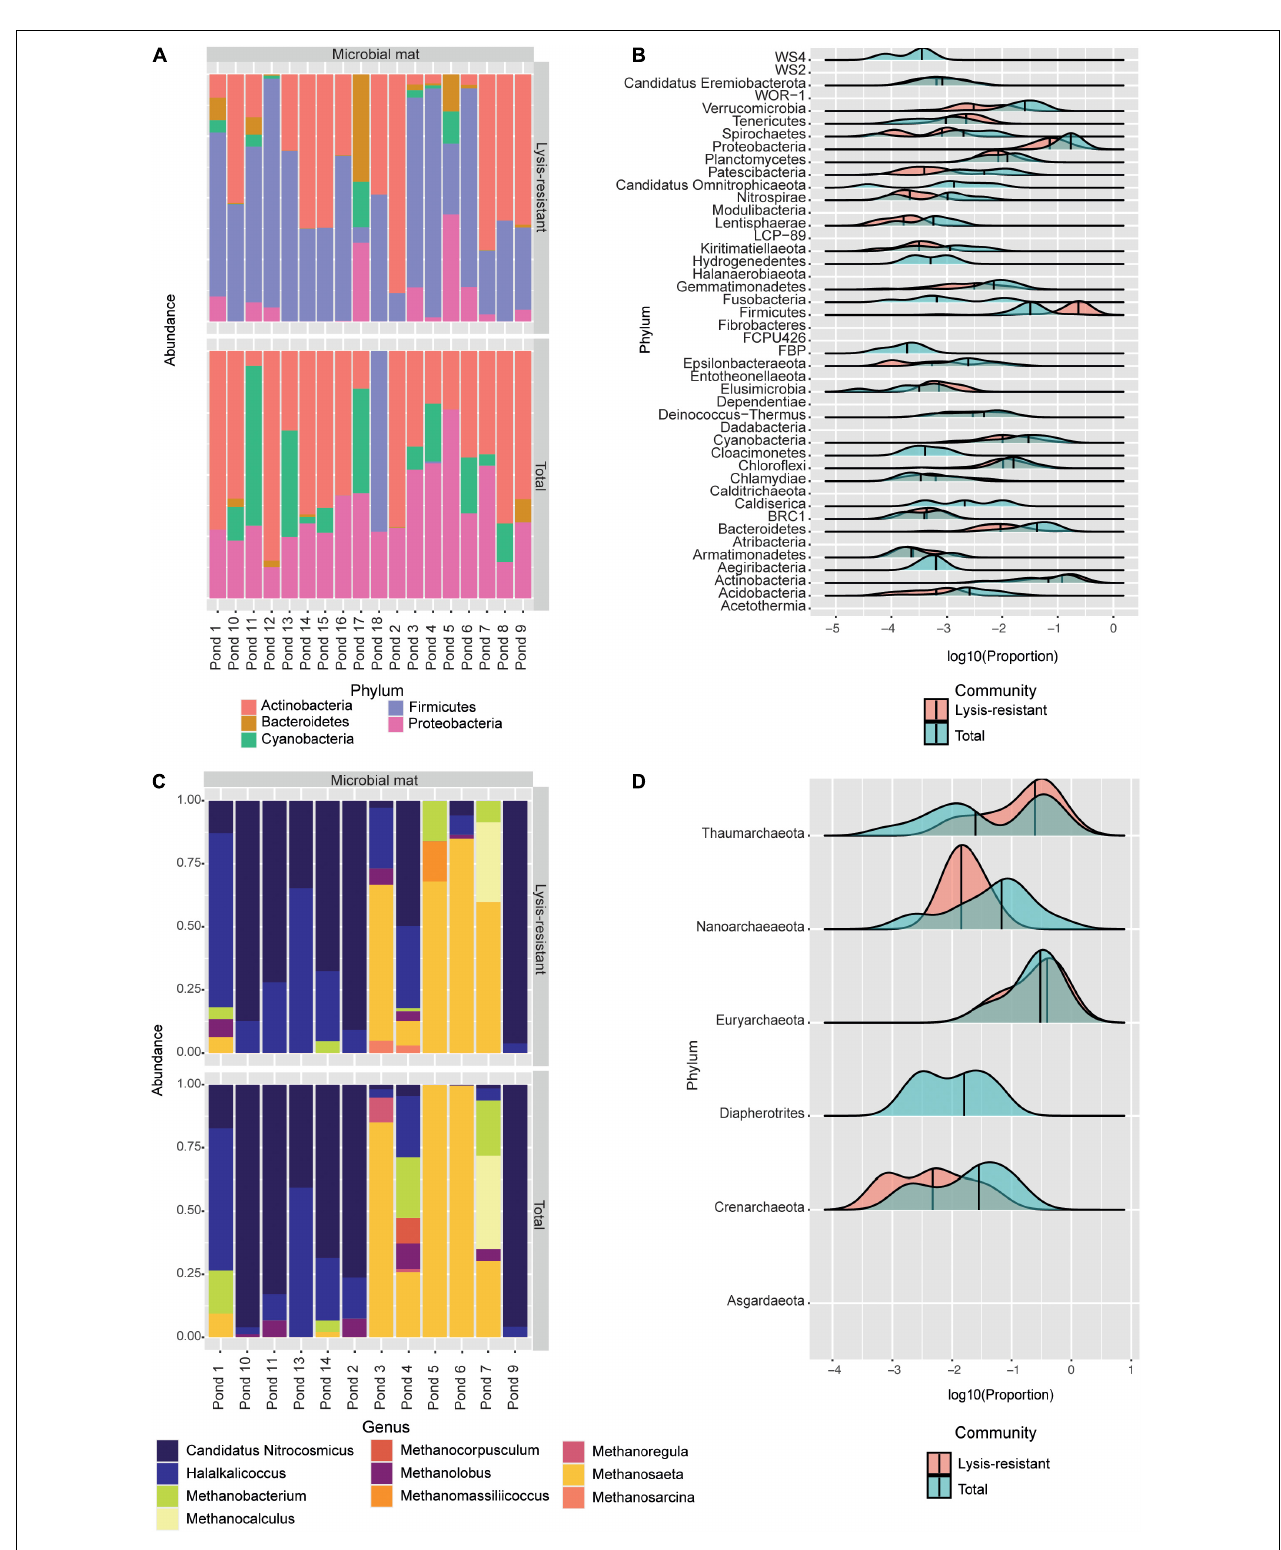
FIGURE 6 | (A) Top 50 bacterial ASVs relative abundance per pond at the phylum level. (B) This plot shows the abundance distribution of the different bacterial phyla, for either the lysis-resistant (red) or the total fraction (blue) in the microbial mats. The abundance is shown in log10 of the relative abundance. (C) Top 50 archaeal ASVs relative abundance per pond at the genus level. (D) This plot shows the abundance distribution of the different archaeal genus, for either the lysis-resistant (red) or the total fraction (blue) in the microbial mats. The abundance is shown in log10 of the relative abundance.